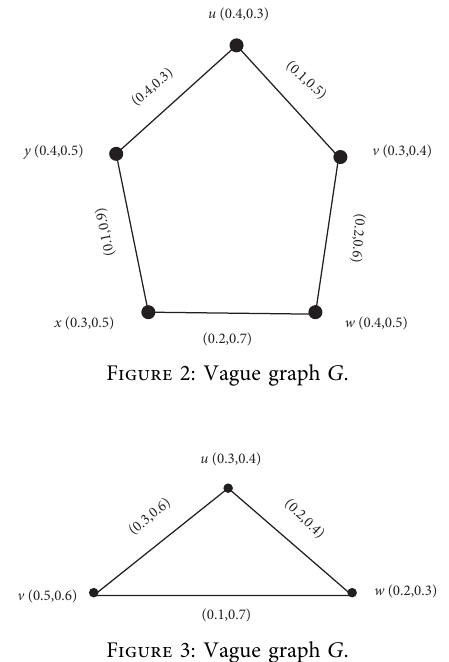
Figure 3: Vague graph G